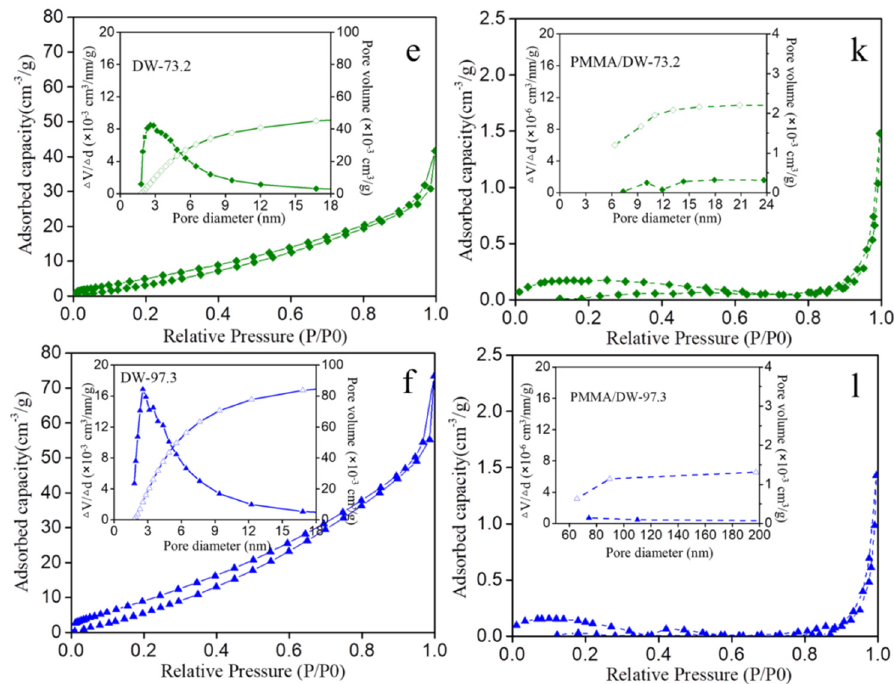
Figure 1. Nitrogen adsorption–desorption isotherms and mesopore-size distribution and accumu- lated pore volume: ( a – f ) DW and ( g – l ) PMMA/DW.